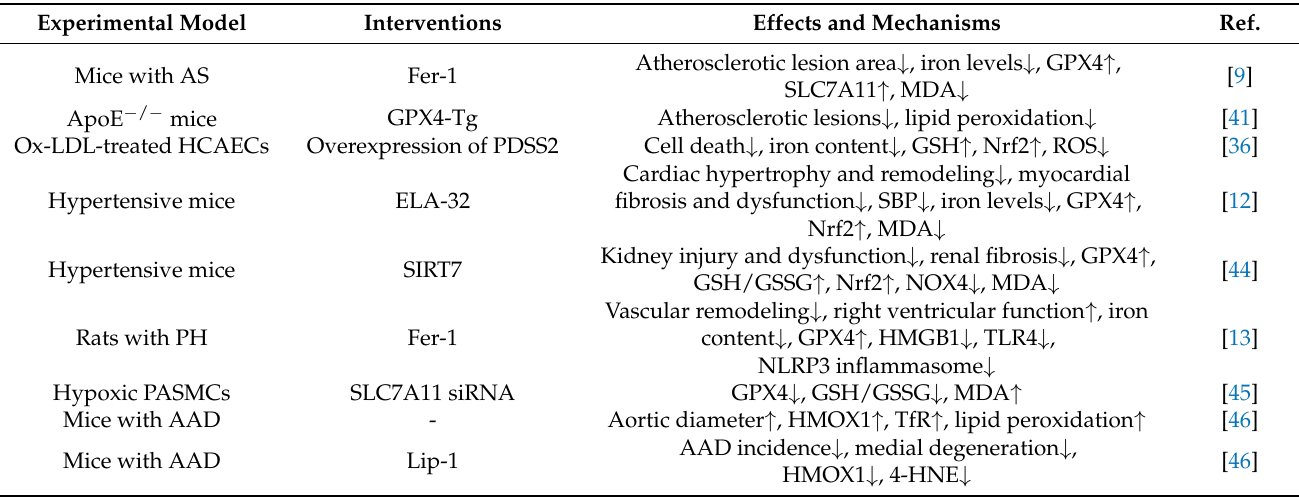
Table 1. Iron metabolism and ferroptosis in vascular diseases. Experimental Model Interventions Effects and